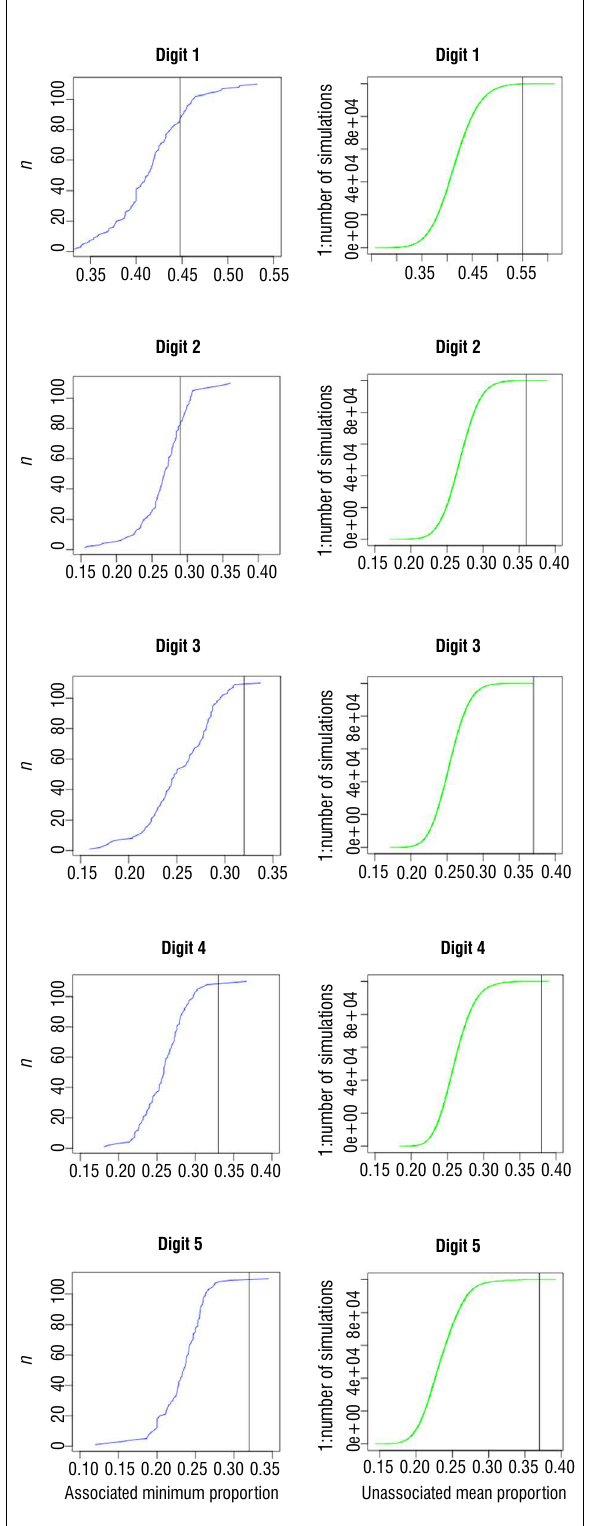
Figure 3: The associated (left) and unassociated (right) modern human cumulative distribution functions (CDFs) for digits 1–5. Each corresponding Homo naledi value is represented by the vertical lines in each of the CDFs. The scales of the axes differ with digit and